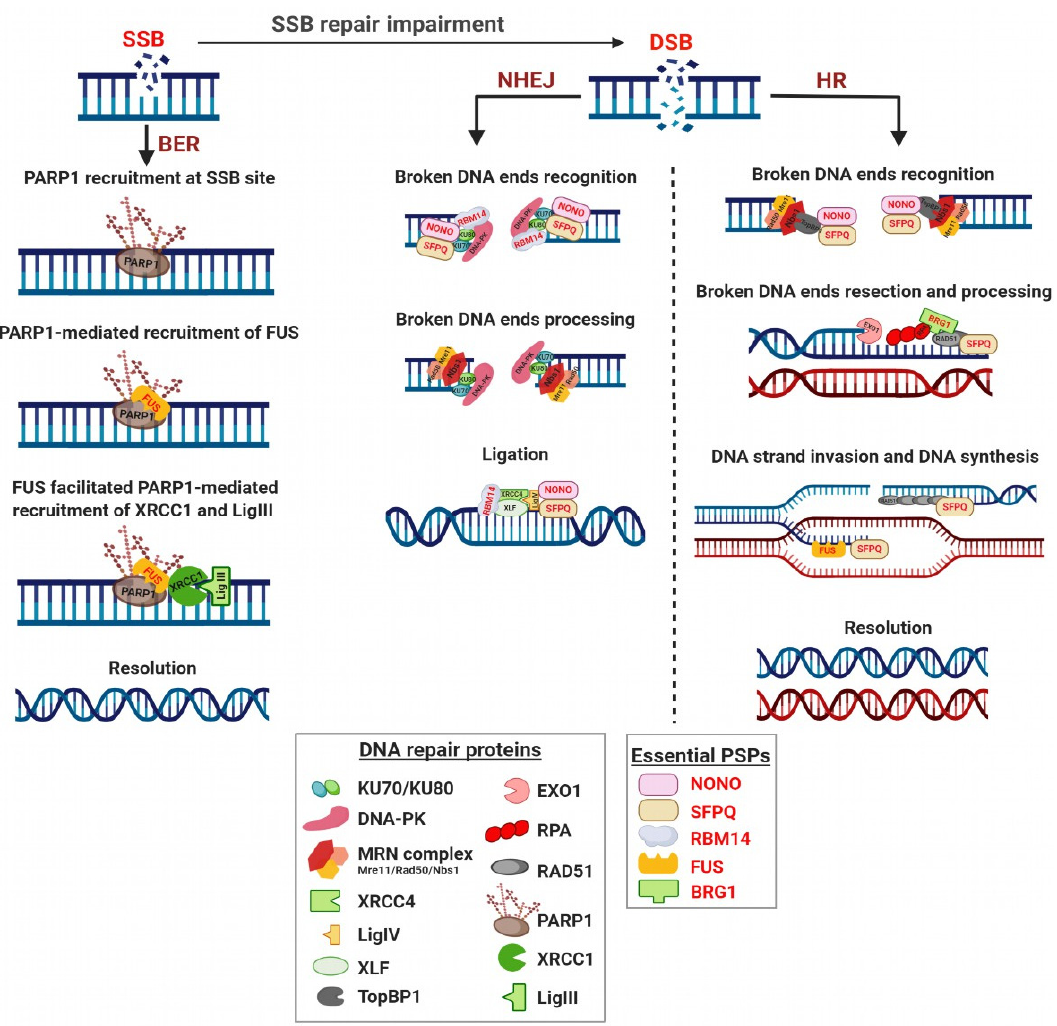
Figure 4. Schematic representation of essential PSPs involvement at different levels of DDR system.